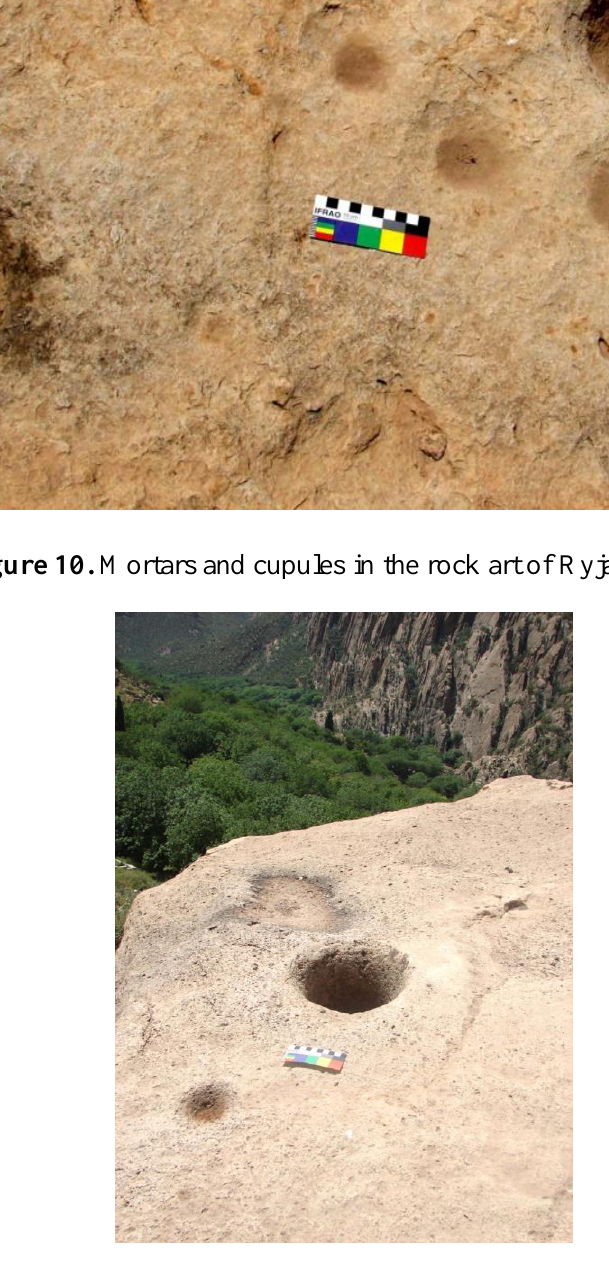
Figure 11. On the horizontal surface of a huge cliff there are a cupule and a